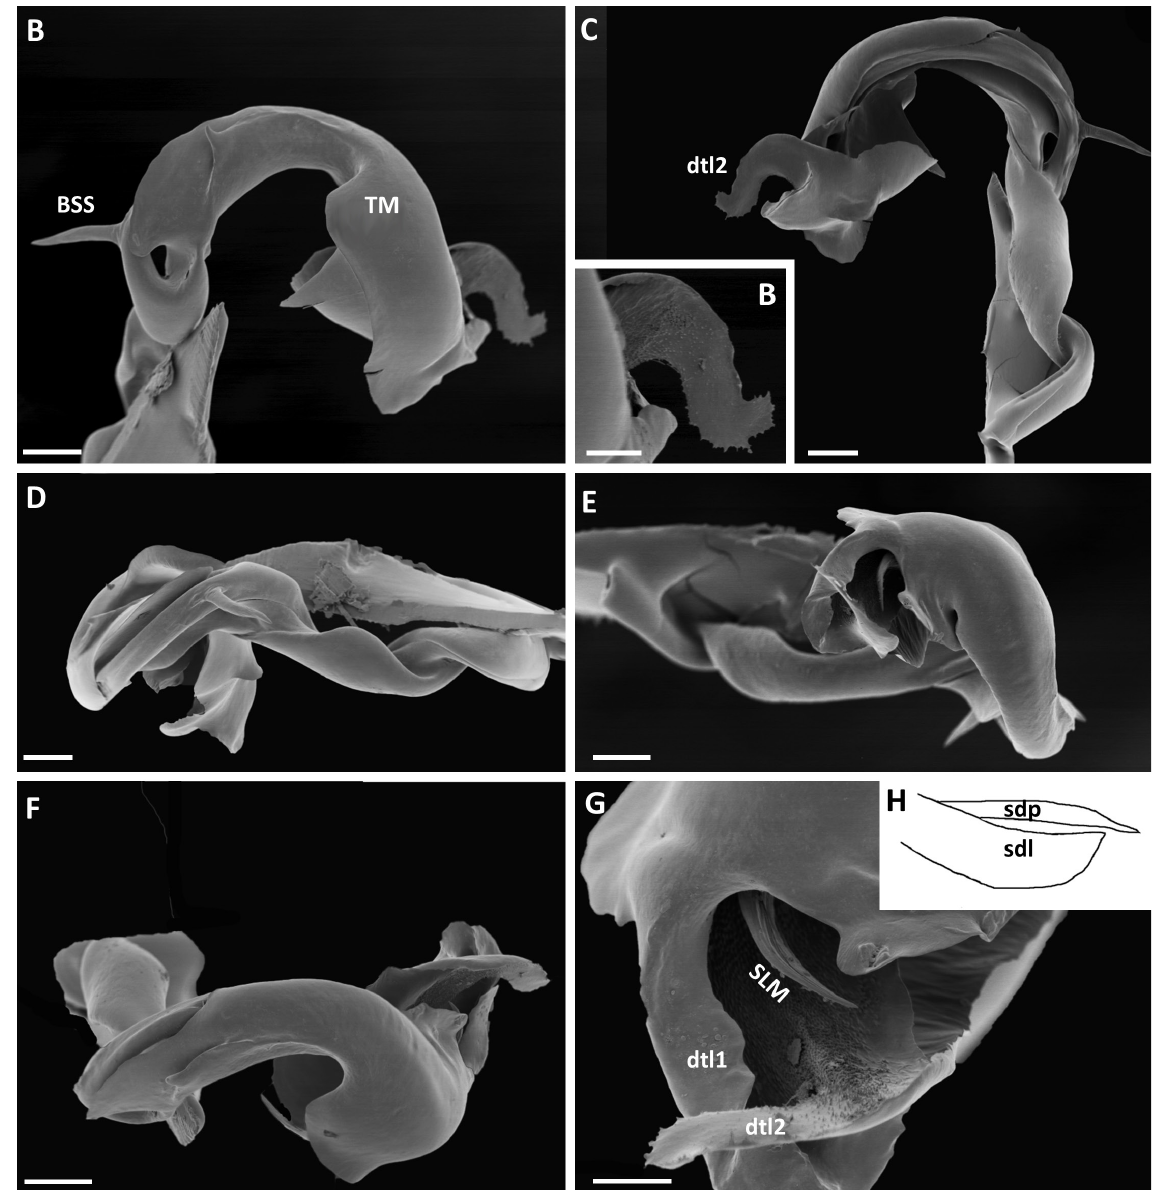
Fig. 70. Xystopyge hippocampus sp. nov., holotype, ♂ (NHMD 621770). A–G . Left gonopod telopodite. A. Anterior view. B. As A, close-up of tip. C. Posterior view. D. Ventral view. E. Dorsal view. F. Mesal view. G. Dorso-mesal view, close-up of tip. H . Right solenomere, tip. Abbreviations: BSS = basal solenomeral spine; dtl1 , dtl2 = distal telomeral lobes; sdl = soloenomeral distal lobe; sdp = solenomeral distal process; SLM = solenomere; TM = telomere. Scale bars: A, C–F = 0.2 mm; B, G = 0.1 mm; H not to